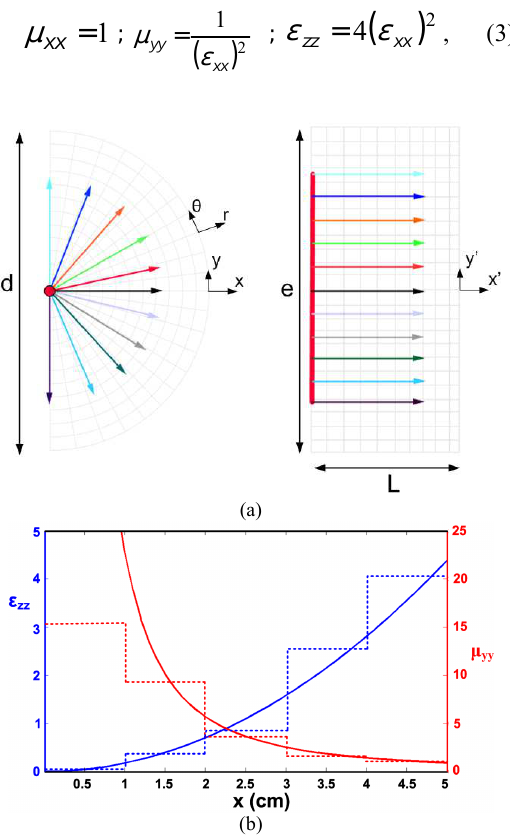
Figure 1: (a) Transformation of a cylindrical space into a rectangular one. (b) Continuous (continuous lines) and discretized (dashed lines) variations of permeability and permittivity of the material.